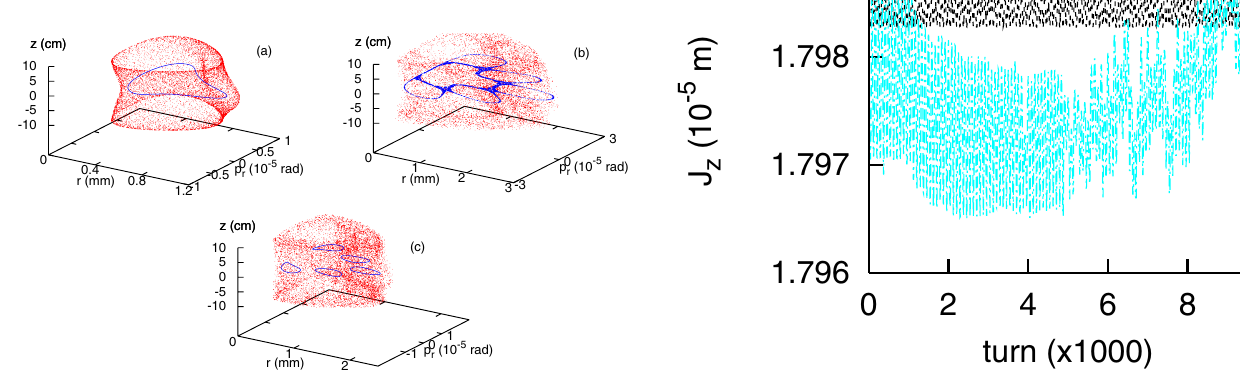
(cid:1) z space: (a) near FIG. 9. (Color) Evolution of J r in Fig. 8. Black and light blue lines correspond to (cid:12) (cid:5) 0 : 06 and 0.38, respectively.